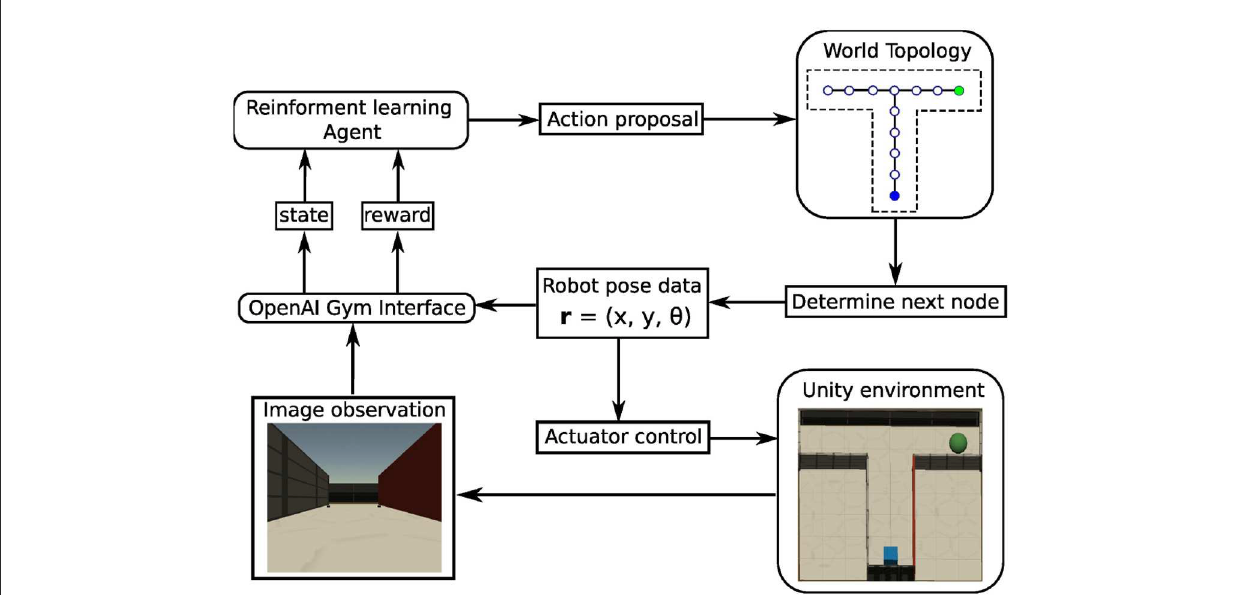
FIGURE2 Schematic of the CoBeL-RL simulation framework. Modules are represented by rounded rectangles, data and commands by regular rectangles. The information or control flows are depicted by arrows.